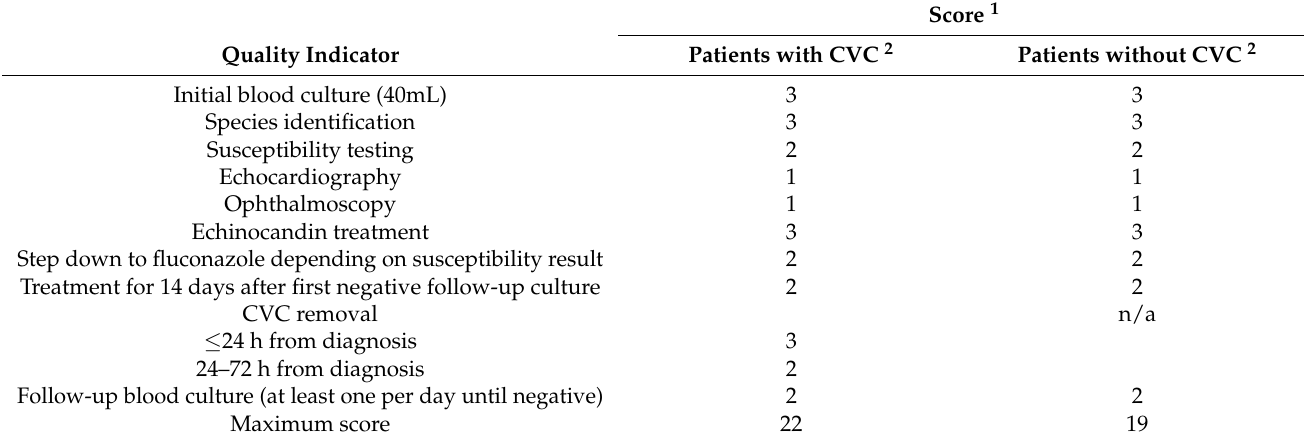
Table 1. EQUAL Candida Score 1